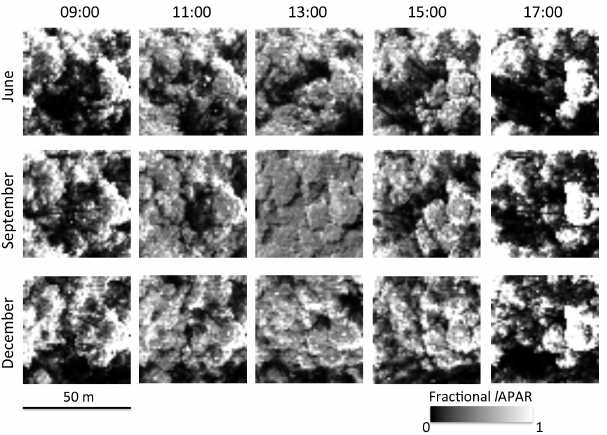
Figure 3. Illumination geometry alters the distribution of light ab- sorption by leaves on a diurnal and seasonal basis. Simulation re- sults for June, September, and December illustrate the distribution of fractional l APAR across the model scene under direct illumina- tion conditions, where diffuse light is modeled using observations of aerosol optical depth from AERONET. Fractional l APAR exceeds 1 for some voxel columns with high interception of incoming PAR, especially with low sun angles in the morning (09:00LT) and late afternoon